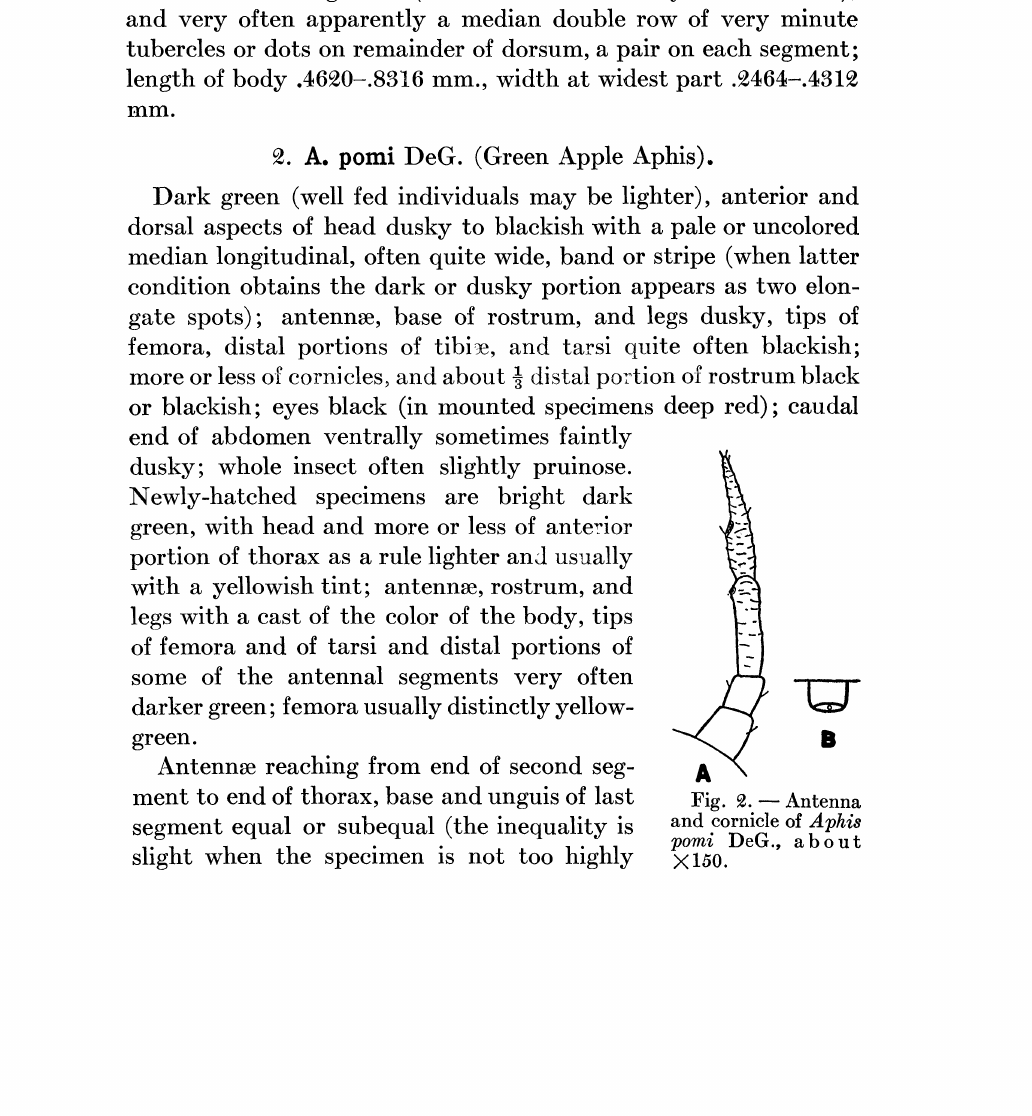
.- Antenna Fig. and cornicle of Aphis pomi DeG., about